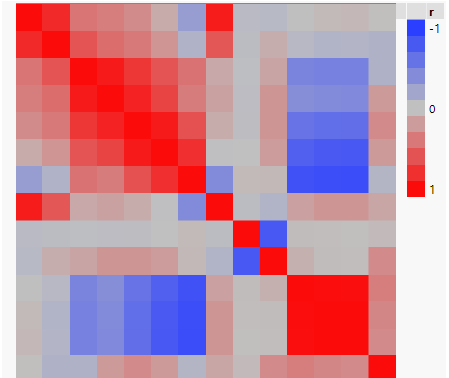
Figure 1. Heat map depict a visualization for the pairwise correlation matrix of the input variables. Each column i and row j shows correlation coefficient r ij . Cells with colors otherthan gray indicate some level of correlation. As the colors get darker the level of correlation goes